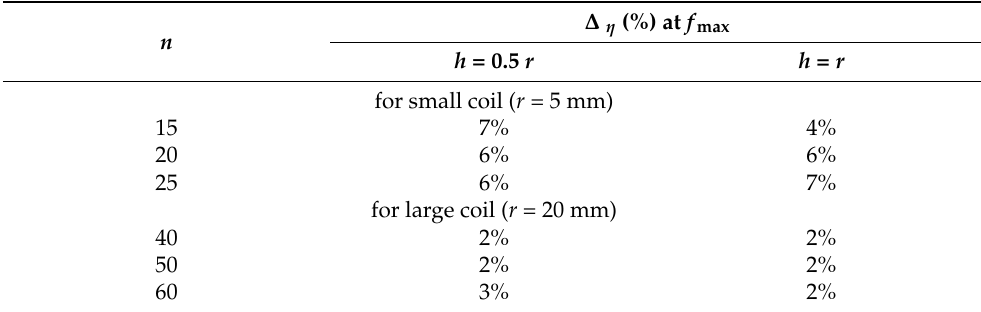
Table 13. The difference between the efficiency of the system in the aperiodic models with circular or square coils.